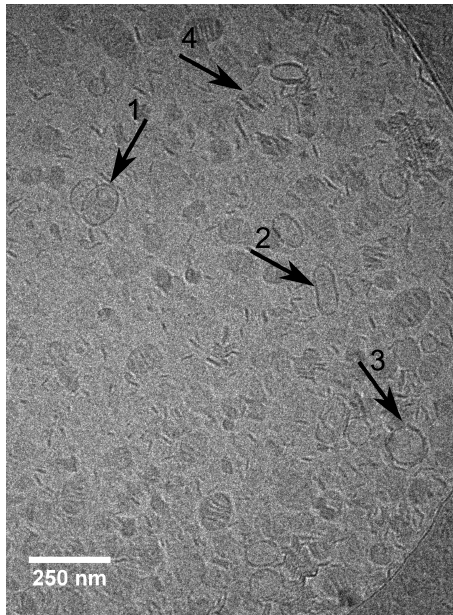
Figure 11. Cryo-TEM image of a sample with 4mol% β -aescin prepared at 10 ◦ C. The arrows point on deformed SUVs (1), elongated SUVs (2), SUVs with edges (3) and stacks of bilayer disks (4). Reproduced from Ref. [48] with permission of